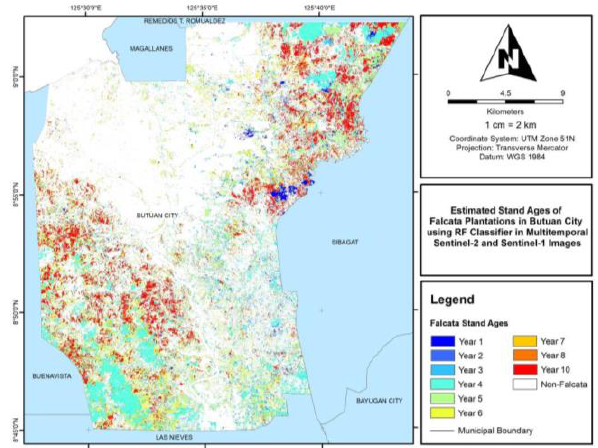
Figure 7. Map of the stand ages of Falcata plantations generated through RF classification of multitemporal Sentinel-1 and Sentinel-2 data and